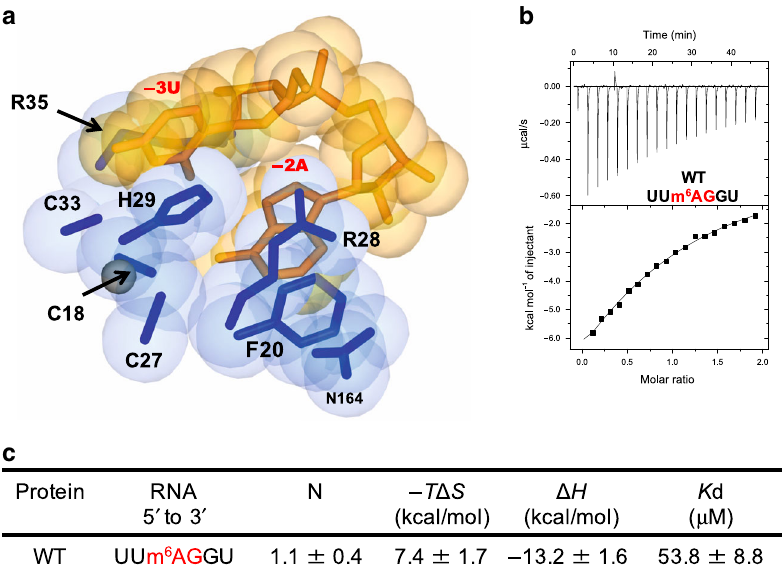
Fig. 3 Speci fi c interaction between the N 6 amino group of − 2A base and Cys27. a Space- fi lling representation around the − 2A base. The side chains of the U2AF1 amino-acid residues are shown in blue, and the RNA bases in orange. The interface around − 2A base is intimately surrounded by the amino- acid residues of U2AF1. Thus, no space is found for the N 6 -methyl modi fi cation of the – 2A base to interact with U2AF1. b Binding af fi nity of U2AF1 WT for the methyl modi fi ed RNA, 5 ′ -UUm 6 AGGU, measured by ITC. Raw data and the corresponding binding curve are depicted. c RNA-binding activities calculated by ITC measurements. Mean value for the dissociation constant ( K d ) with standard deviation is based on three independent